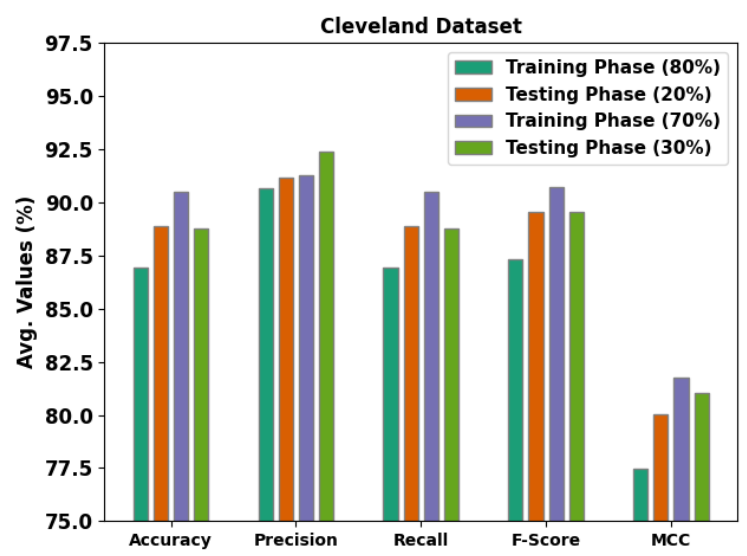
Figure 5. Average analysis results of the MLMDMC-ED algorithm on the Cleveland dataset.